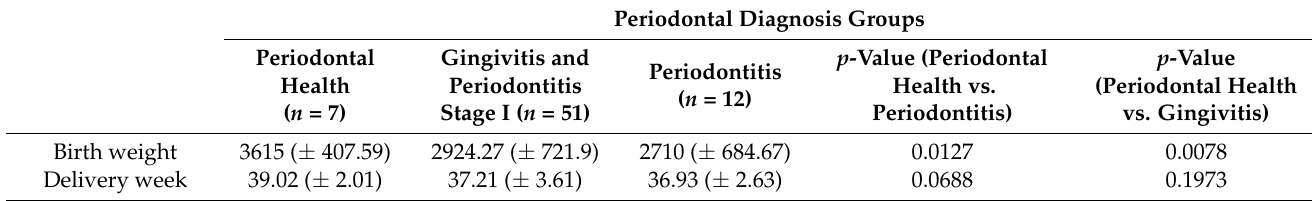
Table 4. Birth outcome parameters and labor data according to periodontal diagnosis. Explorative p -values by Kruskal–Wallis Test without Bonferroni